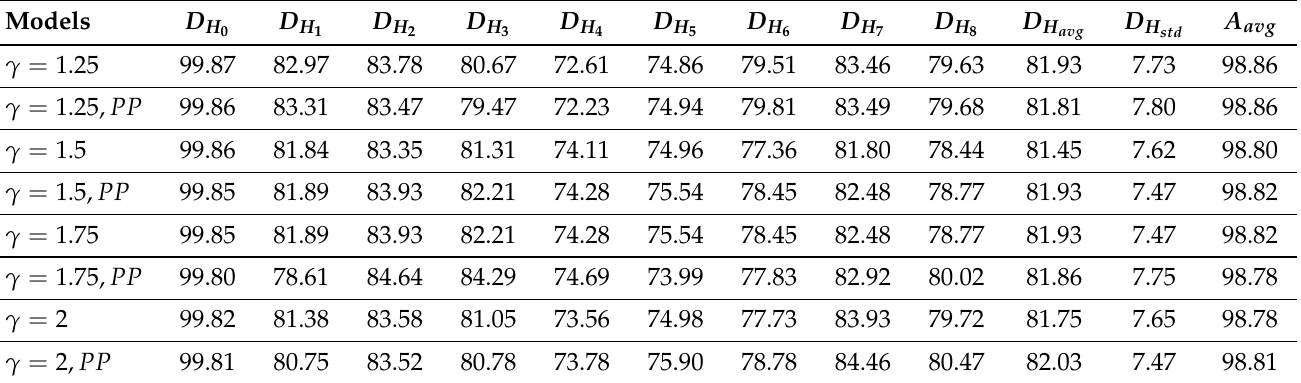
Table 4. Results for the models trained with the FDL B formulation, as defined in Equation (13). Comparisons for the different liver segments. PP stands for Post-Processing. D H coefficient for class t . It is reported as a percentage. D H standard deviation of D H . The average accuracy is denoted as A avg . t